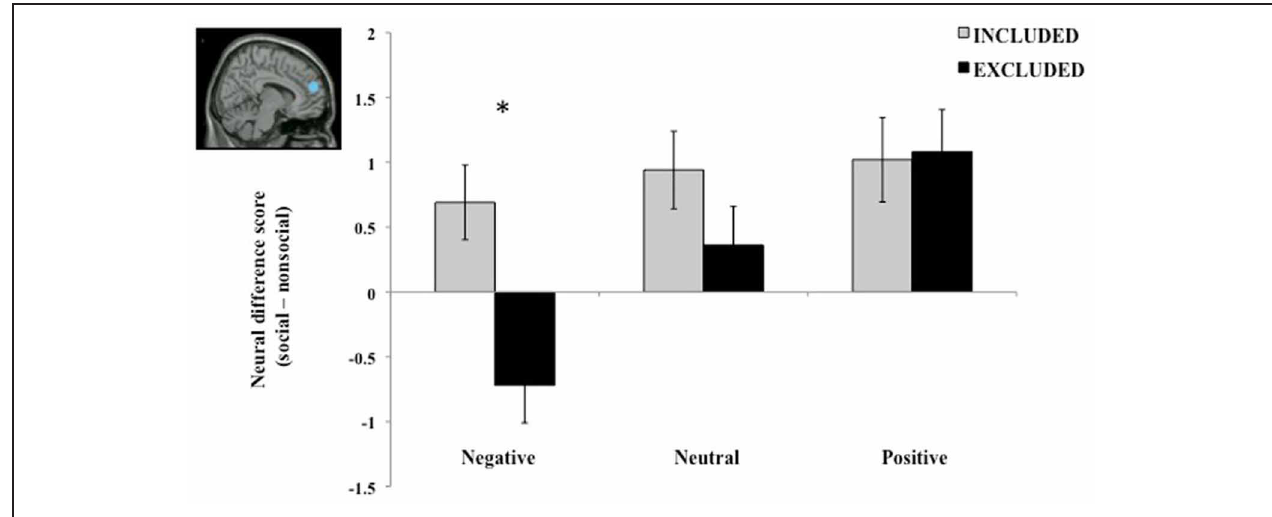
FIGURE 1 | Following social exclusion, activity in dmPFC, a brain region involved in mentalizing, (1) is reduced when viewing negative social scenes, and (2) increases in a linear fashion across valence categories (from negative to neutral to positive). Inset displays location of dmPFC